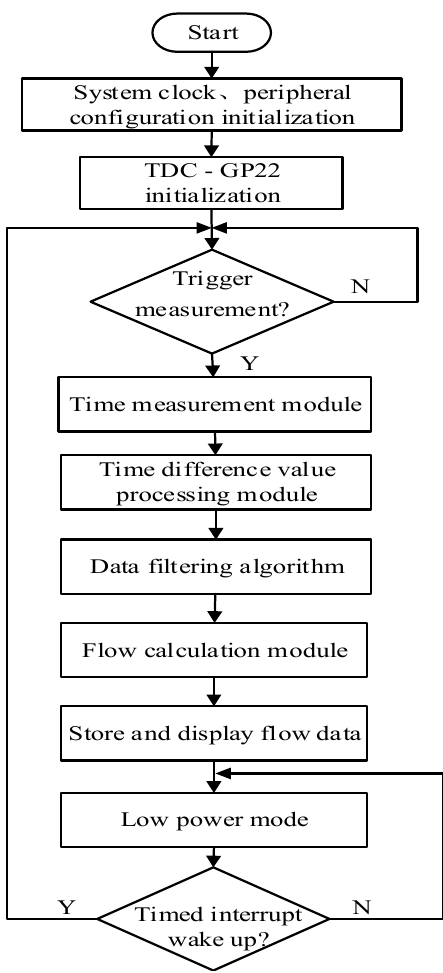
Figure 7. System software flow chart.